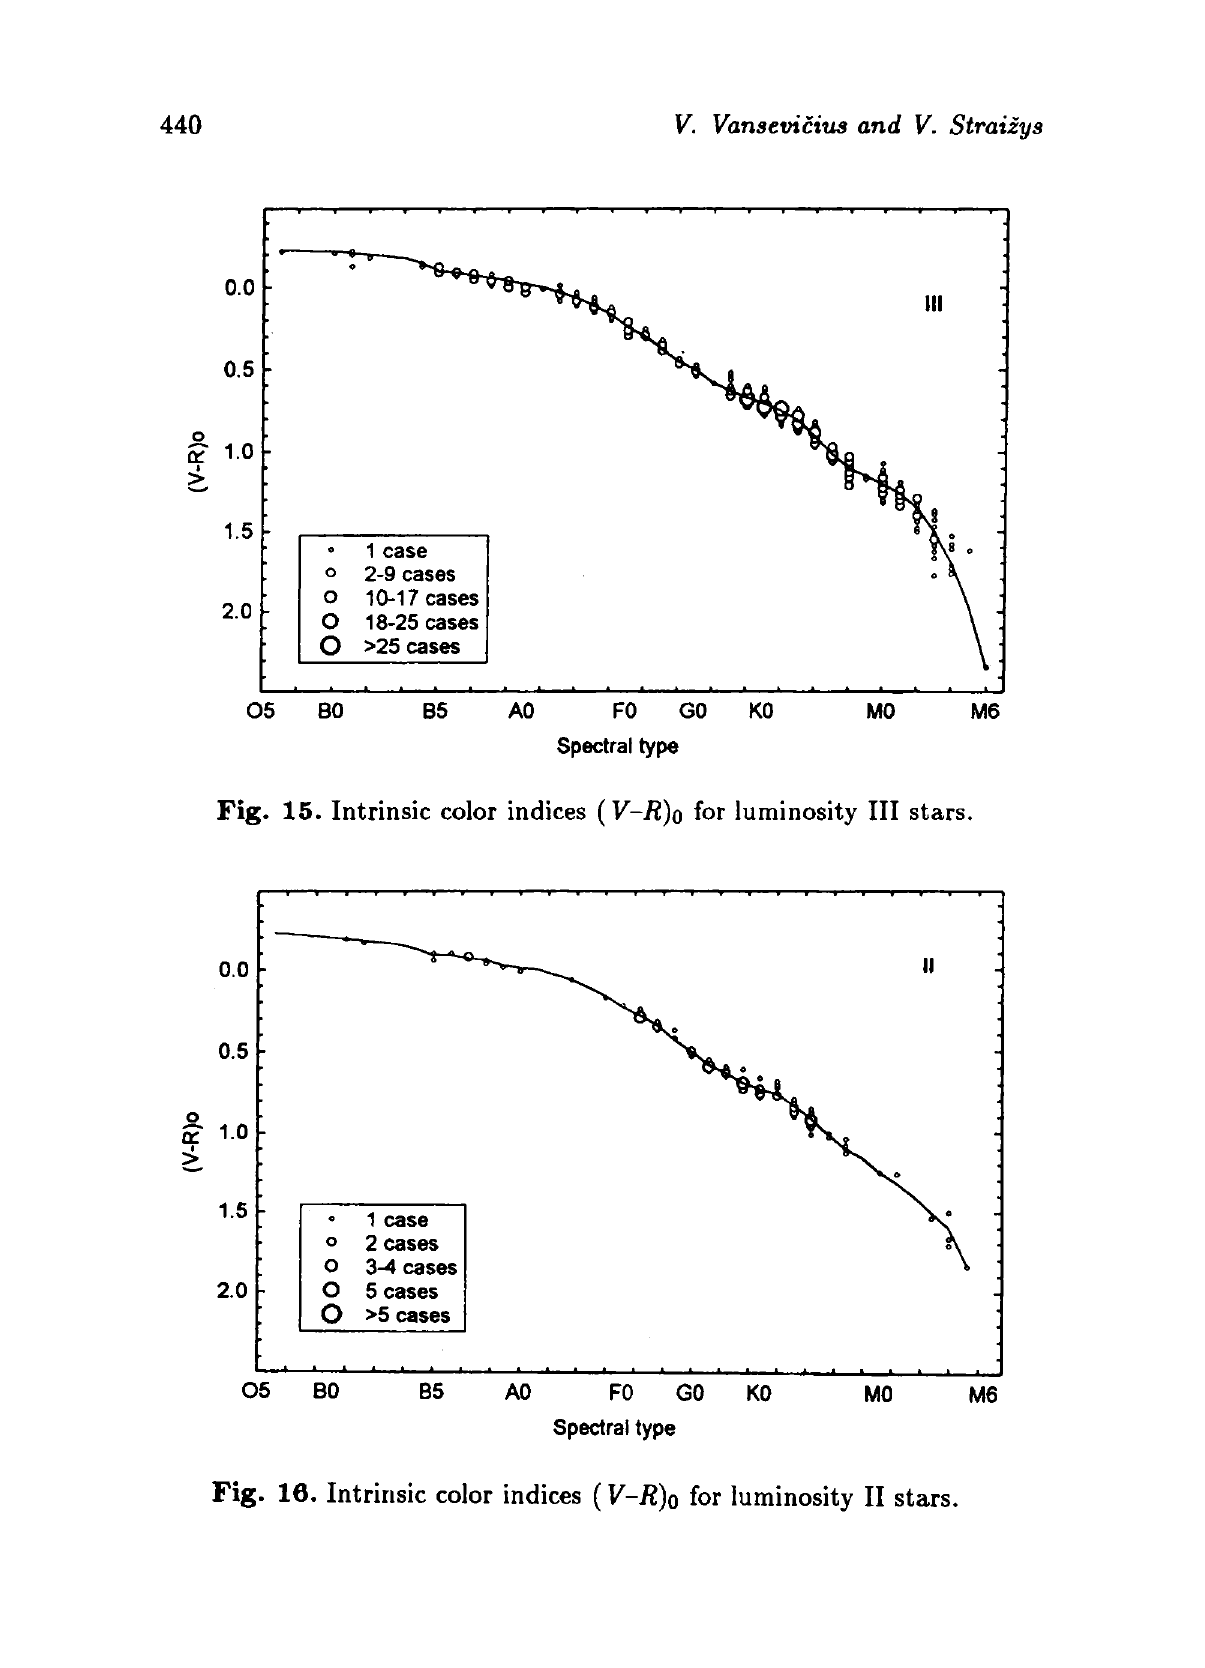
Fig. 16. Intrinsic color indices ( V-R) o for luminosity II